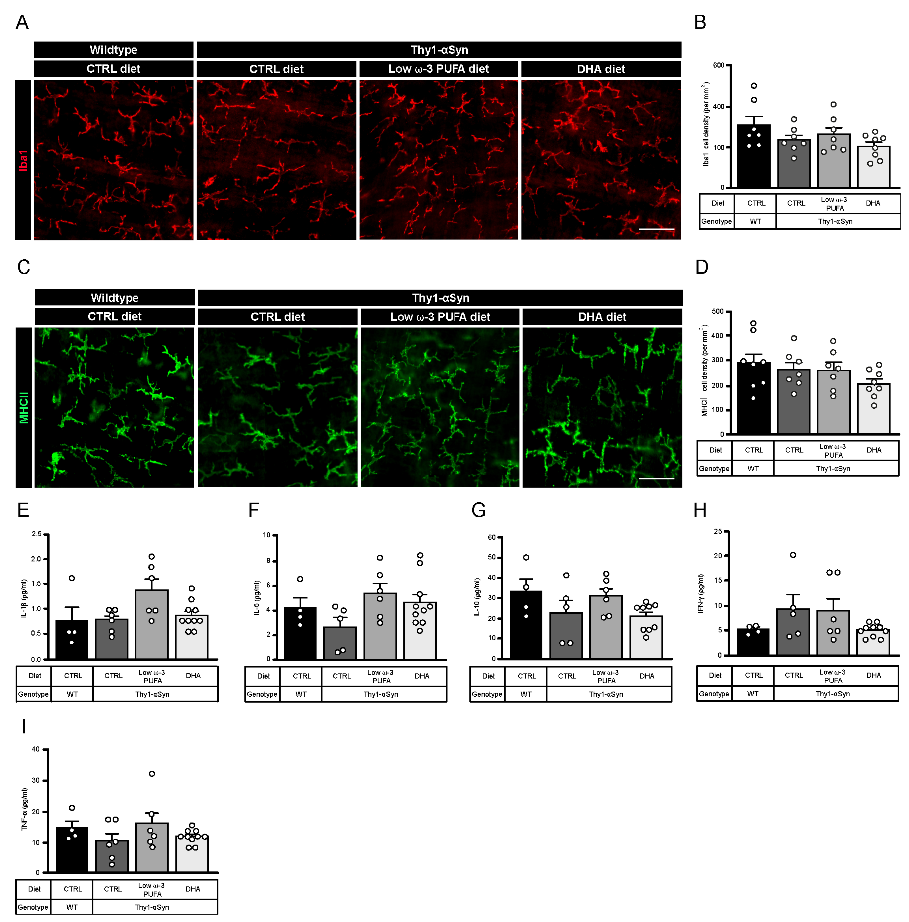
Figure 4. Thy1- α Syn mice do not show change in enteric macrophages and plasma cytokines composition. ( A ) Photomicrographs of Iba1 + macrophage immunofluorescence (red) in wild-type mice and the Thy1- α Syn model maintained on different diets. Scale bar = 30 µ m. ( B ) Quantification of Iba1 + macrophages by density shows no significant difference between each group (one-way ANOVA: p = 0.1071). ( C ) Photomicrographs of MHCII + macrophage immunofluorescence (green) in wild-type mice and the Thy1- α Syn model maintained on different diets. Scale bar = 30 µ m. ( D ) Quantification of MHCII + macrophages by density shows no significant difference between each group (one-way ANOVA: p = 0.2537). ( E – I ) Plasma cytokines analysis reveals no difference between mice strains and diets for IL-1 β ( E ), IL-5 ( F ), IL-10 ( G ), IFN- γ ( H ) and TNF- α ( I ). Abbreviations: CTRL, control; DHA, docosahexaenoic acid; Iba1, ionized calcium-binding adapter molecule 1; IFN- γ , interferon gamma; IL, interleukin; MHCII, major histocompatibility complex class II; TNF- α , tumor necrosis factor alpha; WT, wild-type. (white dots) show an increase of varicosities per 100 µ m of dendrites in transgenic mice fed with DHA-enriched diet compared to control